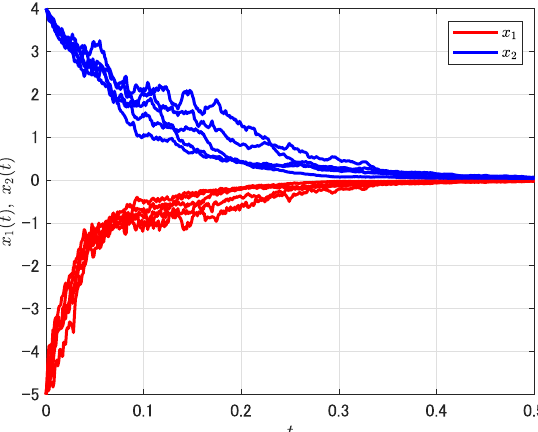
Figure 1. State trajectories of the SUSS under SW 1 in Example